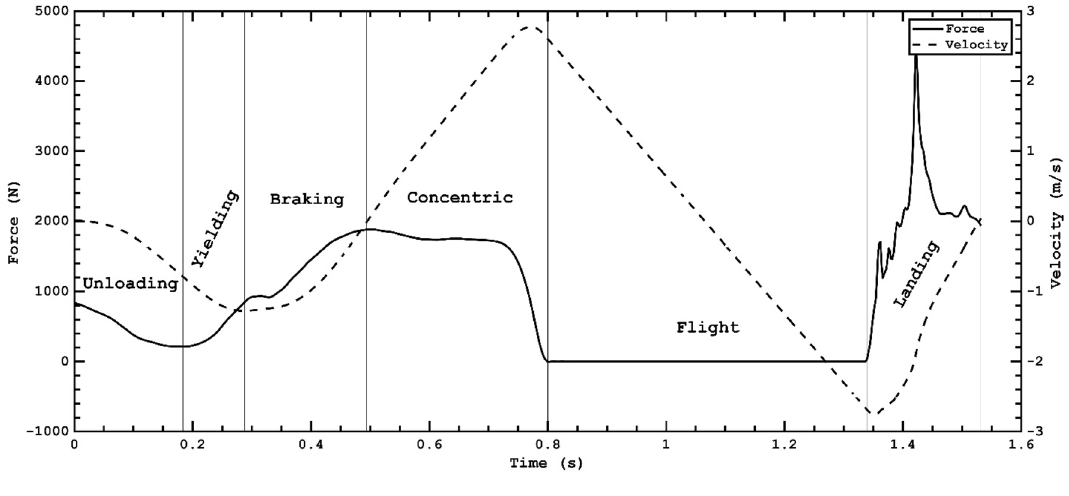
Figure 5. Phases of